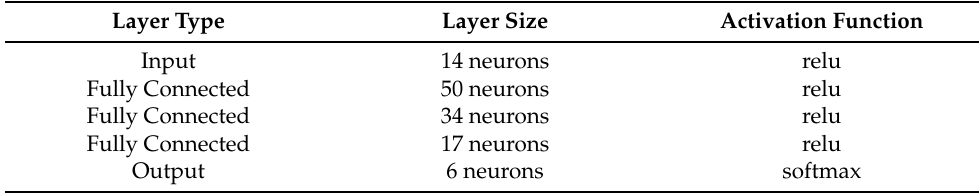
Table 8. DNN Structure: